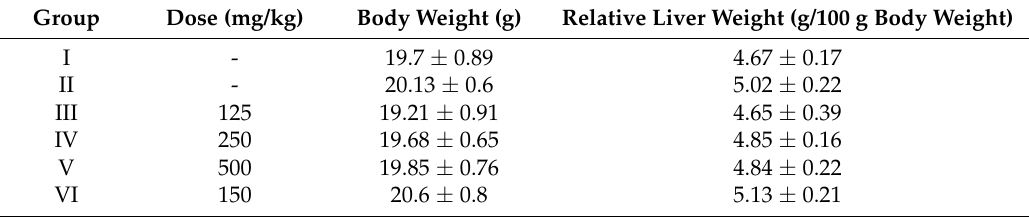
Table 1. Effect of AEOV on body weight and liver index in mice.